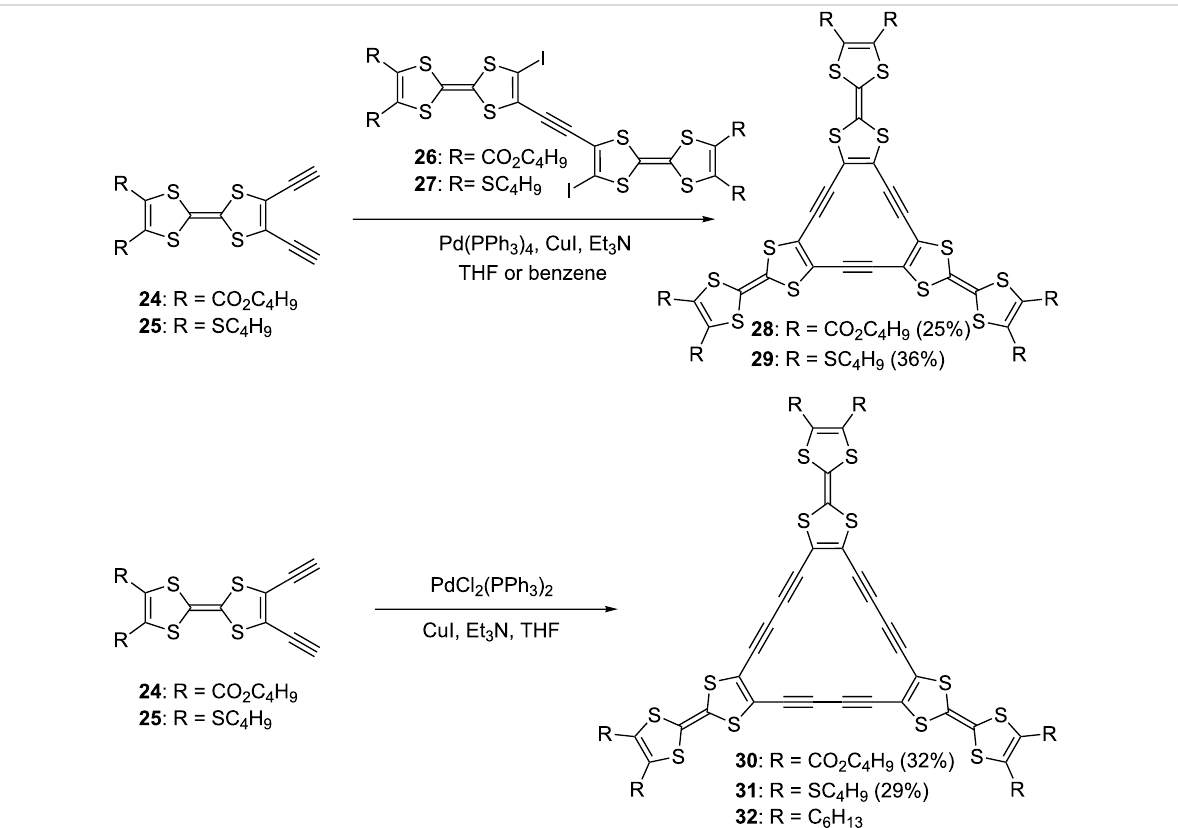
Scheme 2: Synthesis of tris(TTF)[12]annulenes 28 and 29 and tris(TTF)[18]annulenes 30 and 31 , together with hexyl-substituted tris(TTF)[18]annu- lene 32